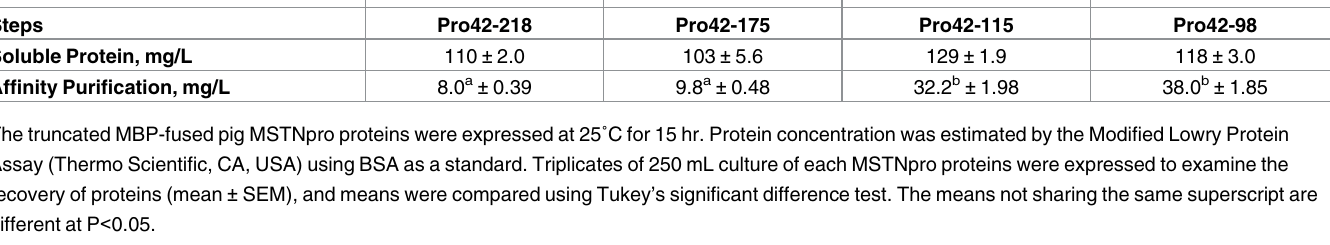
Table 2. Yield of MBP-fused pig MSTNpro proteins recoveredfrom amylose affinity purification.